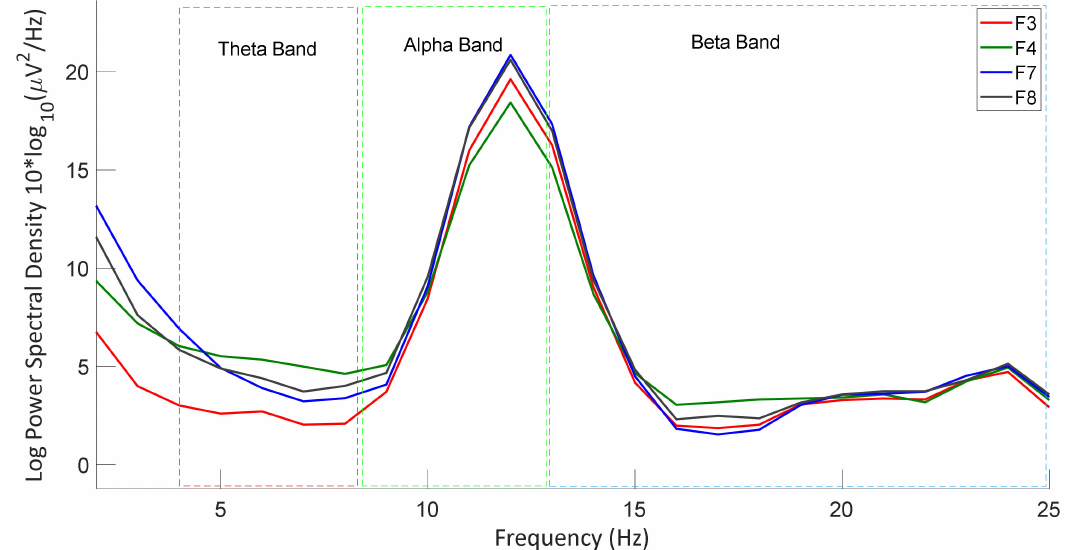
Figure 8. Power spectral density of each band for memory “recall”